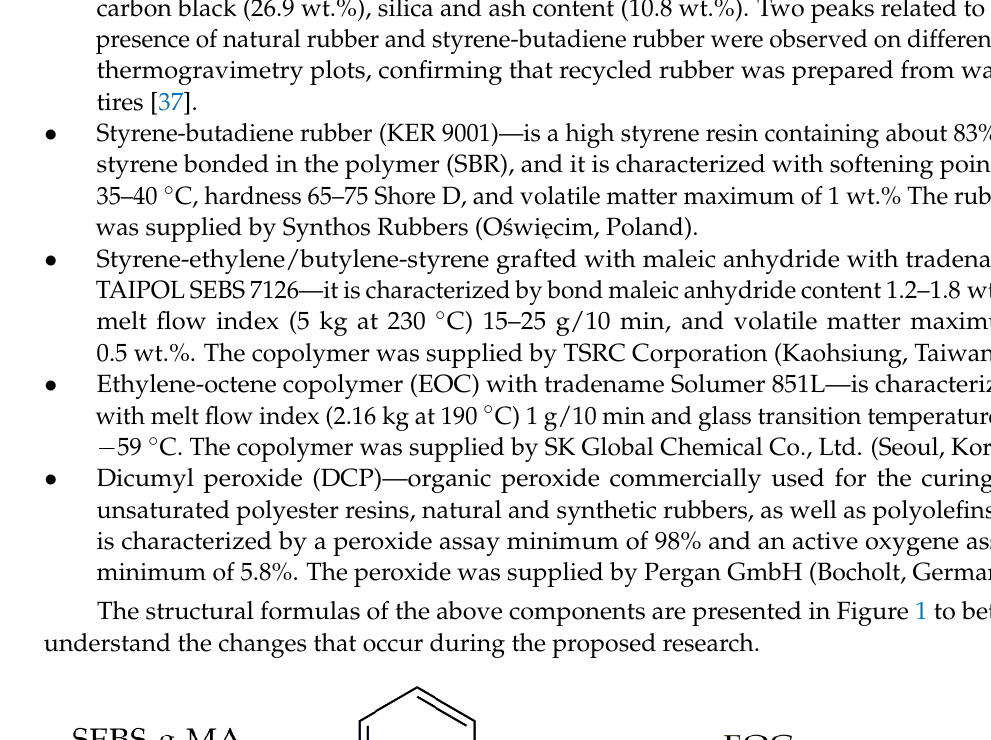
Sample coding, GTR modification and formulation procedure are summarized in Table